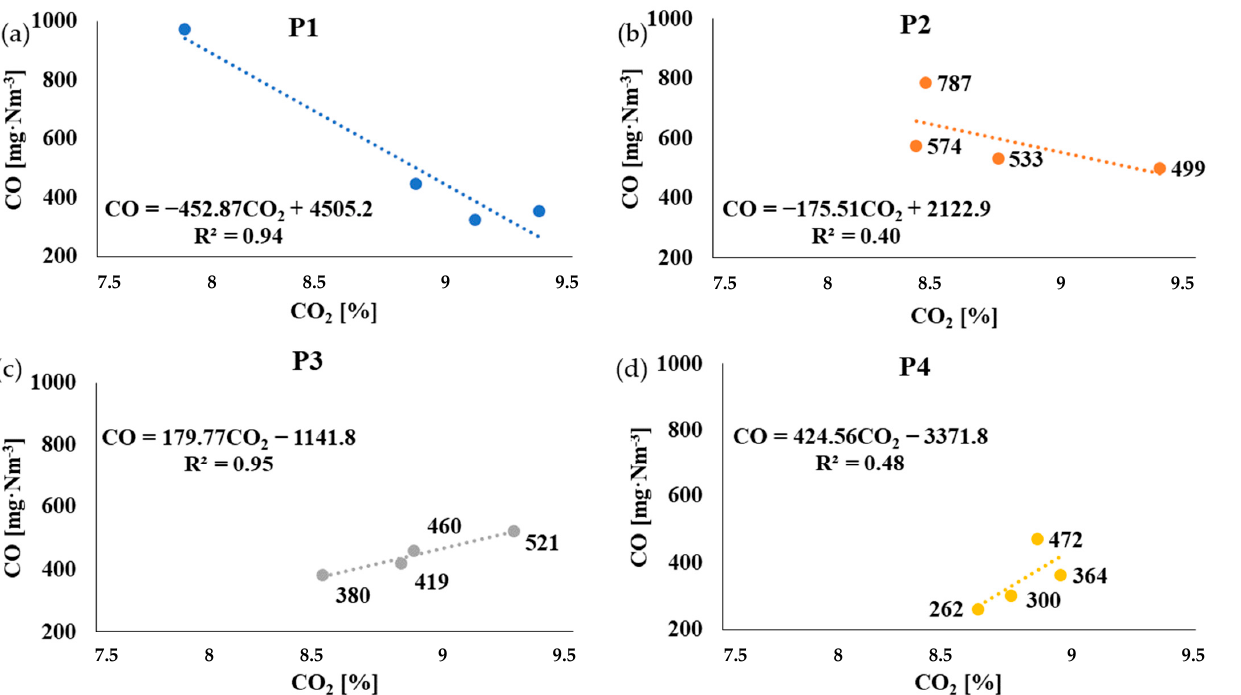
Figure 8. Correlations between CO 2 and CO emissions during pellet combustion ( a ) P1, ( b ) P2, ( c ) P3, and ( d ) P4.